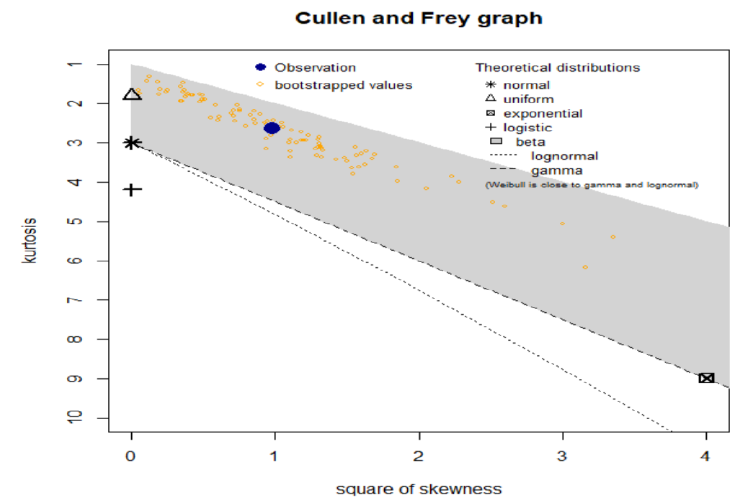
Figure 8. Cullen – Frey plot for the actuarial claims data.